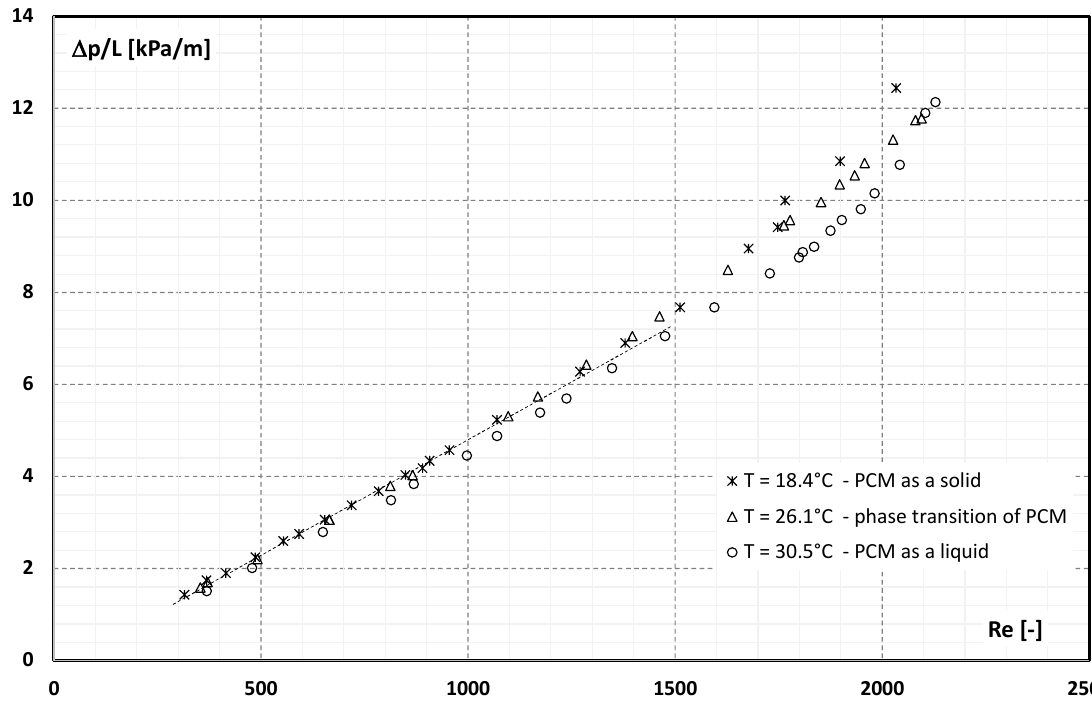
Figure 5. The slurry flow resistance (21.5% MPCM) as a function of Reynolds number and temper- ature.